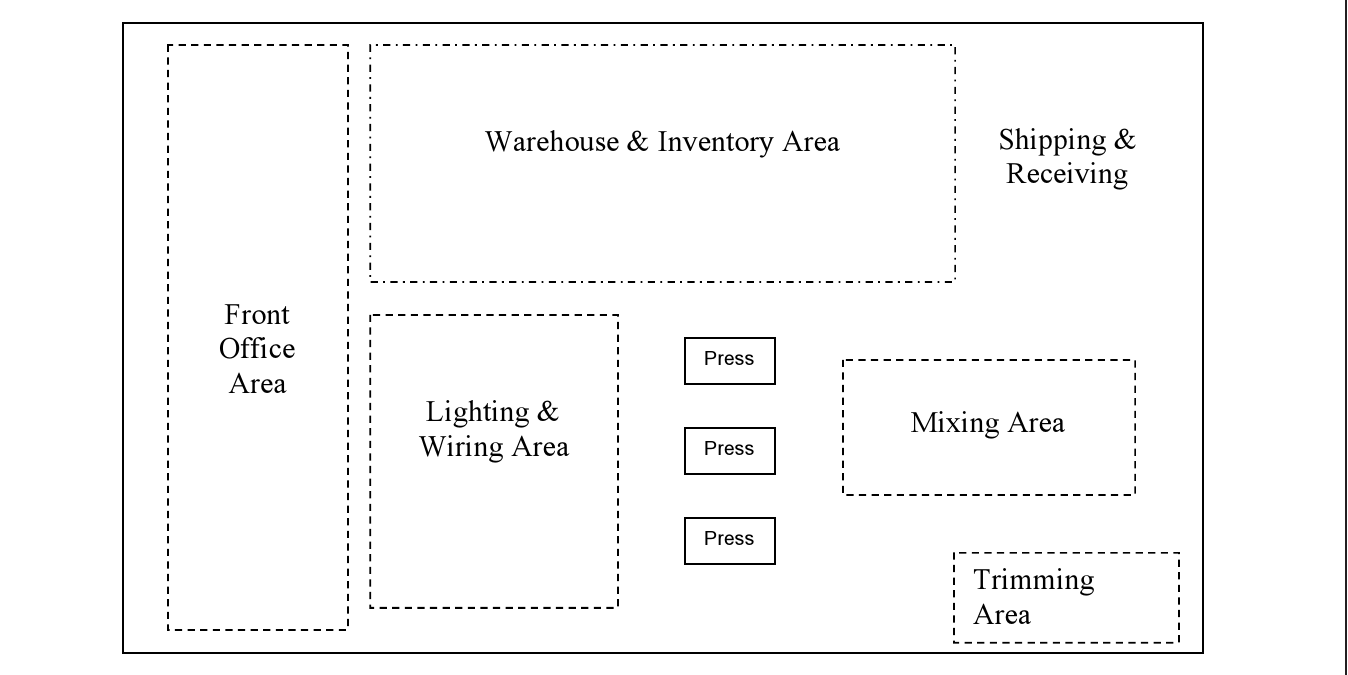
Figure 4. TransLighting Manufacturing Plant